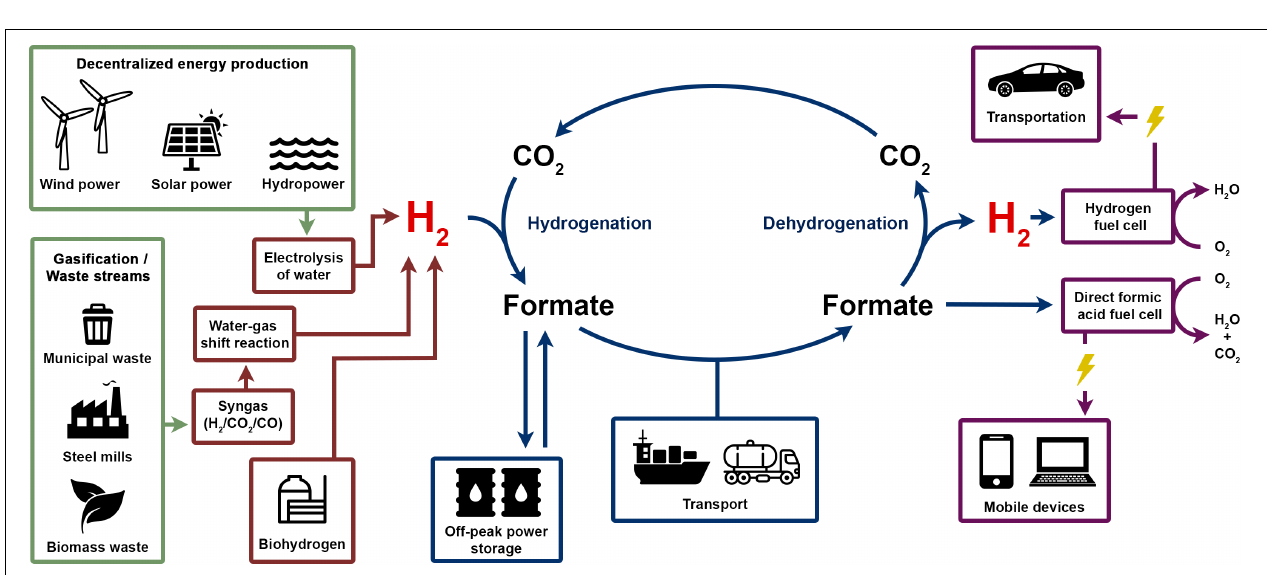
FIGURE 8 | The electron-bifurcating formate dehydrogenase/hydrogenase complex of C. autoethanogenum . The enzyme complex of the acetogenic bacterium C. autoethanogenum consists of a [FeFe] hydrogenase, a formate dehydrogenase and subunits typical for electron bifurcating hydrogenases. It catalyzes electron transfer from H 2 or formate to NADP + and ferredoxin (energetically coupled) and vice versa , or from H 2 to CO 2 forming formate and vice versa . Fd, ferredoxin.